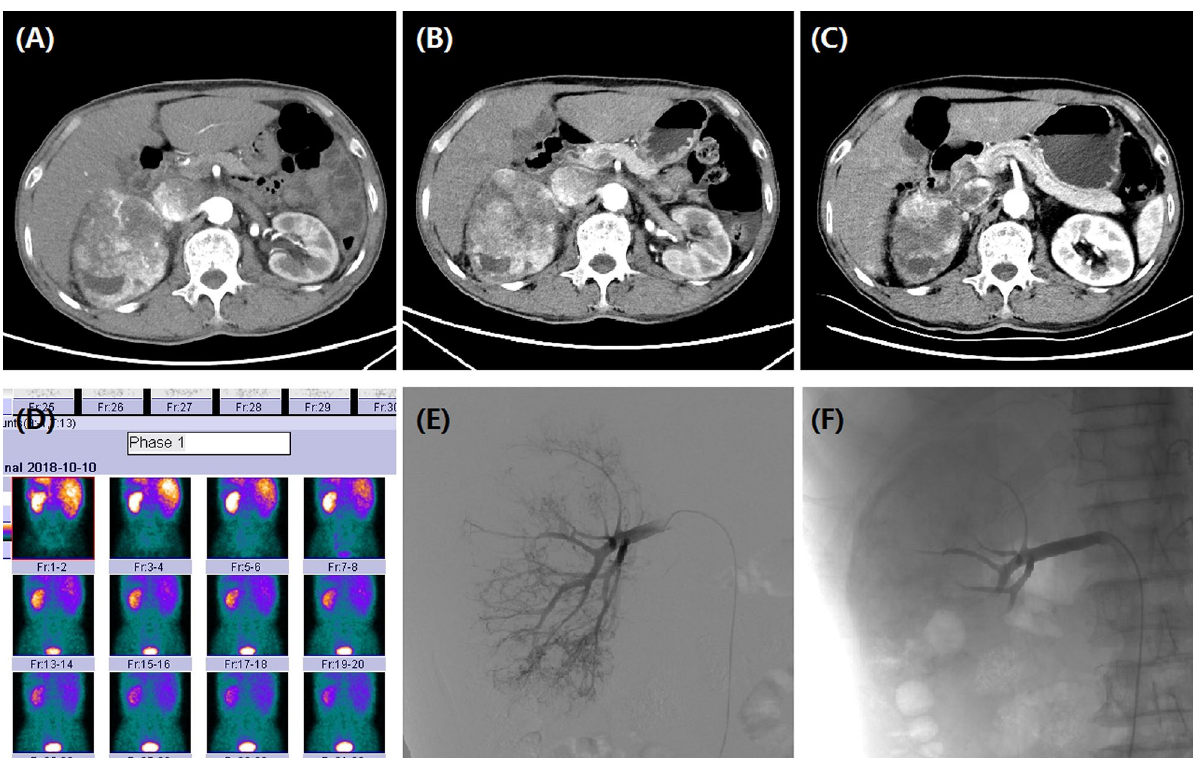
Figure 4. A 72-year male with right RCC treated by CB. ( A ) CT preoperative examination revealed a large tumor of the right kidney with tumor invasion into inferior vena cava. ( B ) The right renal tumor maintained stable after one month’s follow-up. ( C ) The tumor shrunk at 3 months after DEB-TACE. ( D ) The right kidney showed a lower GFR (43.7 ml/min) than the left kidney (60.1 ml/min). ( E ) The right renal artery was the blood supply artery of the tumor. ( F ) The right renal artery was incubated and